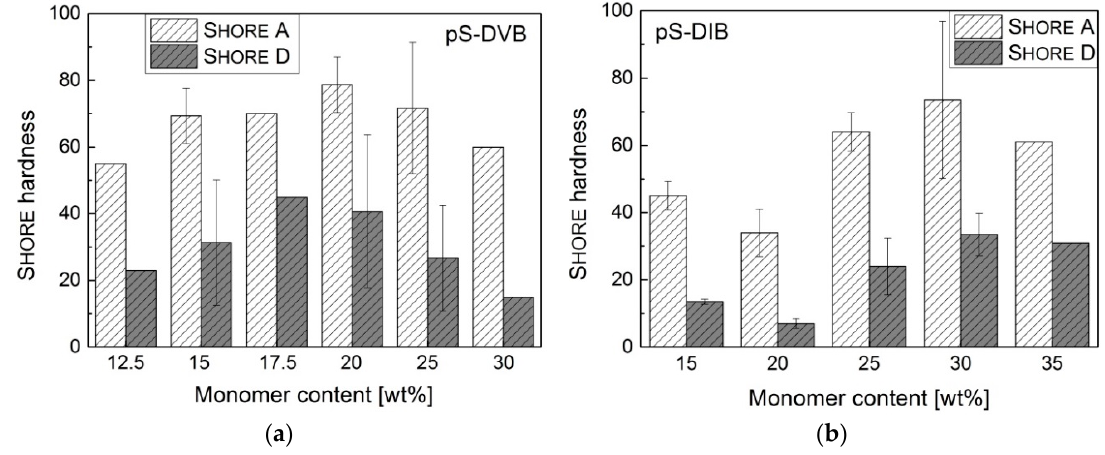
Figure 11. Shore hardness of sulfur copolymers: ( a ) pS-DVB; ( b ) pS-DIB.